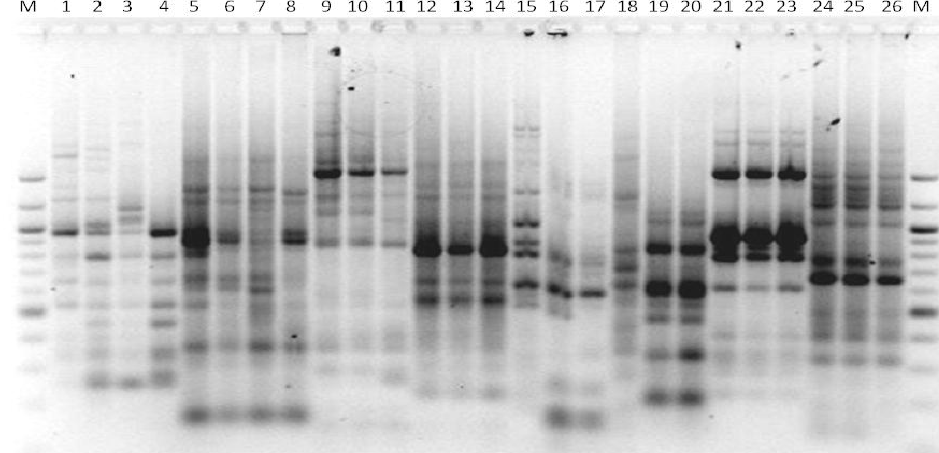
Figure 6. TRtRNA-PCR profiles generated with the primer pair ISSR-MB/TtRNASc (lanes 1–4,